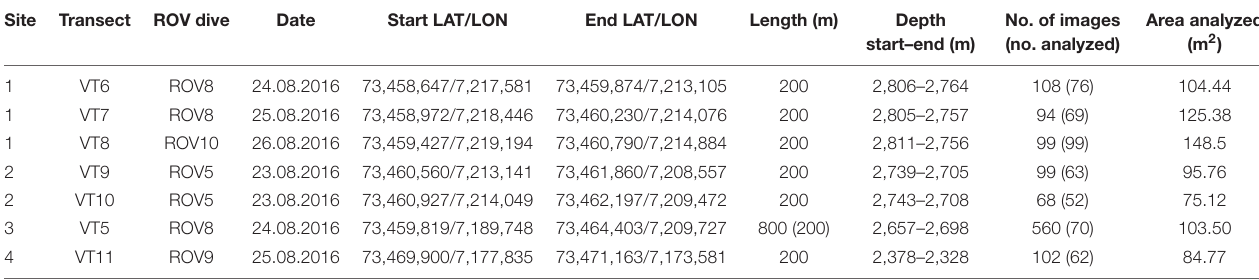
TABLE 1 | Overview of the video transects on the Mohn’s Treasure analyzed in this study. Site Transect ROV